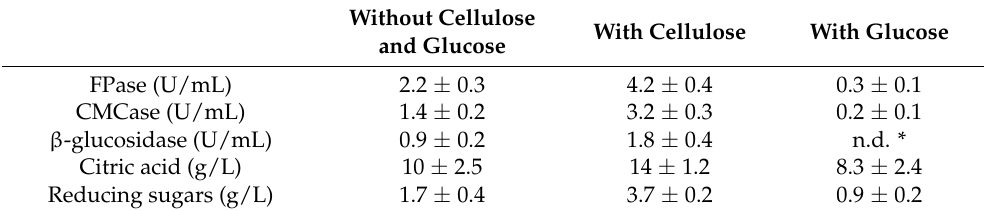
Table 1. Effect of glucose and cellulose on OMW fermentation for the simultaneous production of reducing sugars, citric acid, and cellulase enzyme in a column bioreactor under batch conditions. Without Cellulose With Cellulose With Glucose and Glucose FPase (U/mL) 2.2 ± 0.3 4.2 ± 0.4 0.3 ± 0.1 CMCase (U/mL) 1.4 ± 0.2 3.2 ± 0.3 0.2 ± 0.1 β -glucosidase (U/mL) 0.9 ± 0.2 1.8 ± 0.4 n.d. * Citric acid (g/L) 10 ± 2.5 14 ± 1.2 8.3 ± 2.4 Reducing sugars (g/L) 1.7 ± 0.4 3.7 ± 0.2 0.9 ±